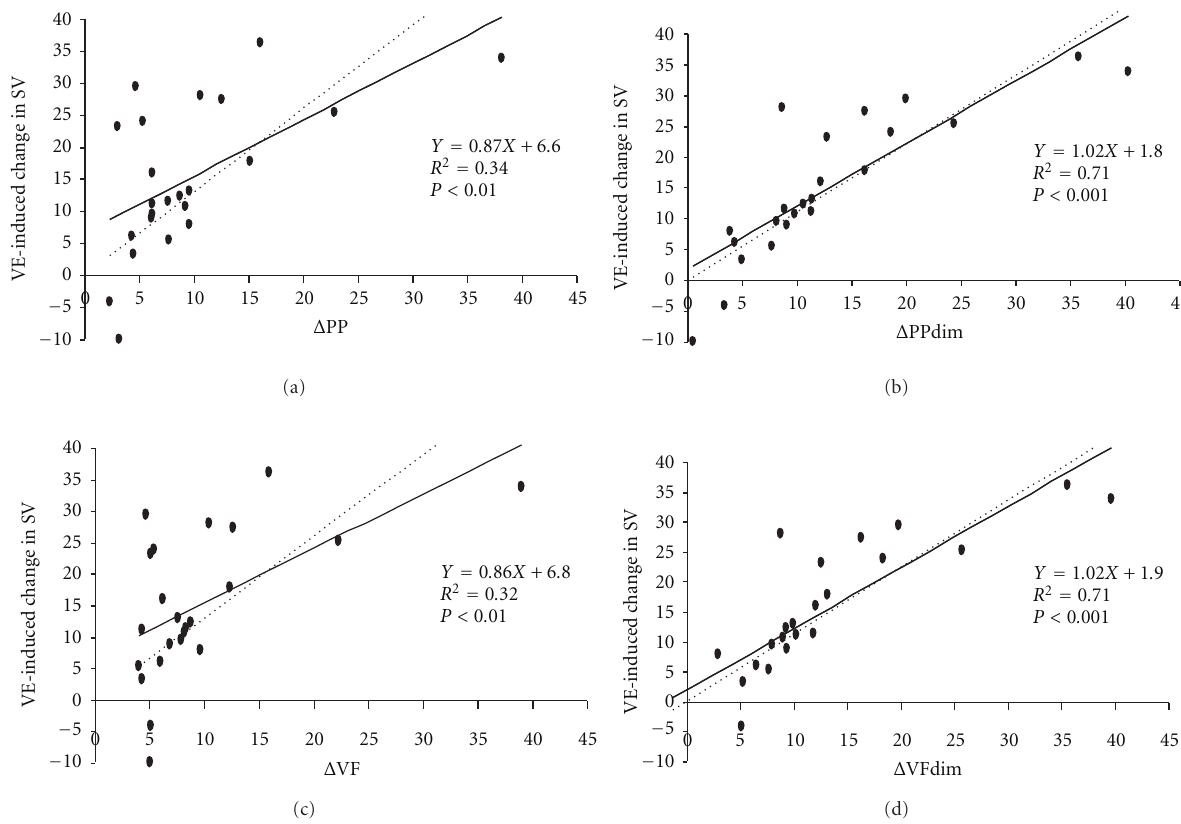
Figure 2: Linear correlation between respiratory change in pulse pressure ( Δ PP), respiratory change in velocity peak of femoral artery flow ( Δ VF), deep inspiration maneuver-induced change in pulse pressure ( Δ PPdim), deep inspiration maneuver-induced change in velocity peak of femoral artery flow ( Δ VFdim)- and volume expansion- (VE-) induced change in stroke volume (SV). Table 2: Velocity peak of femoral artery flow during quiet spontaneous breathing and deep inspiration maneuver in healthy volunteers. VF during quiet spontaneous VF during deep inspiration N